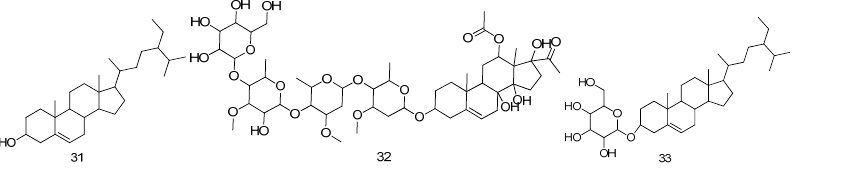
Table 3. The sterol compounds identified from Fructus Malvae.